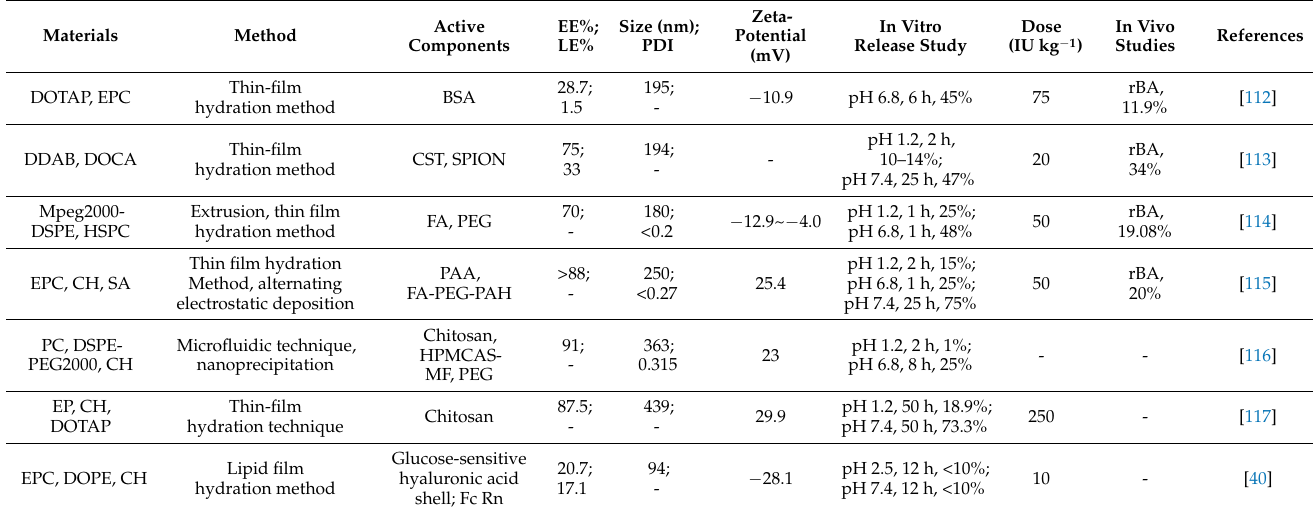
Table 3. Examples of liposomes as a nano structure for oral insulin delivery